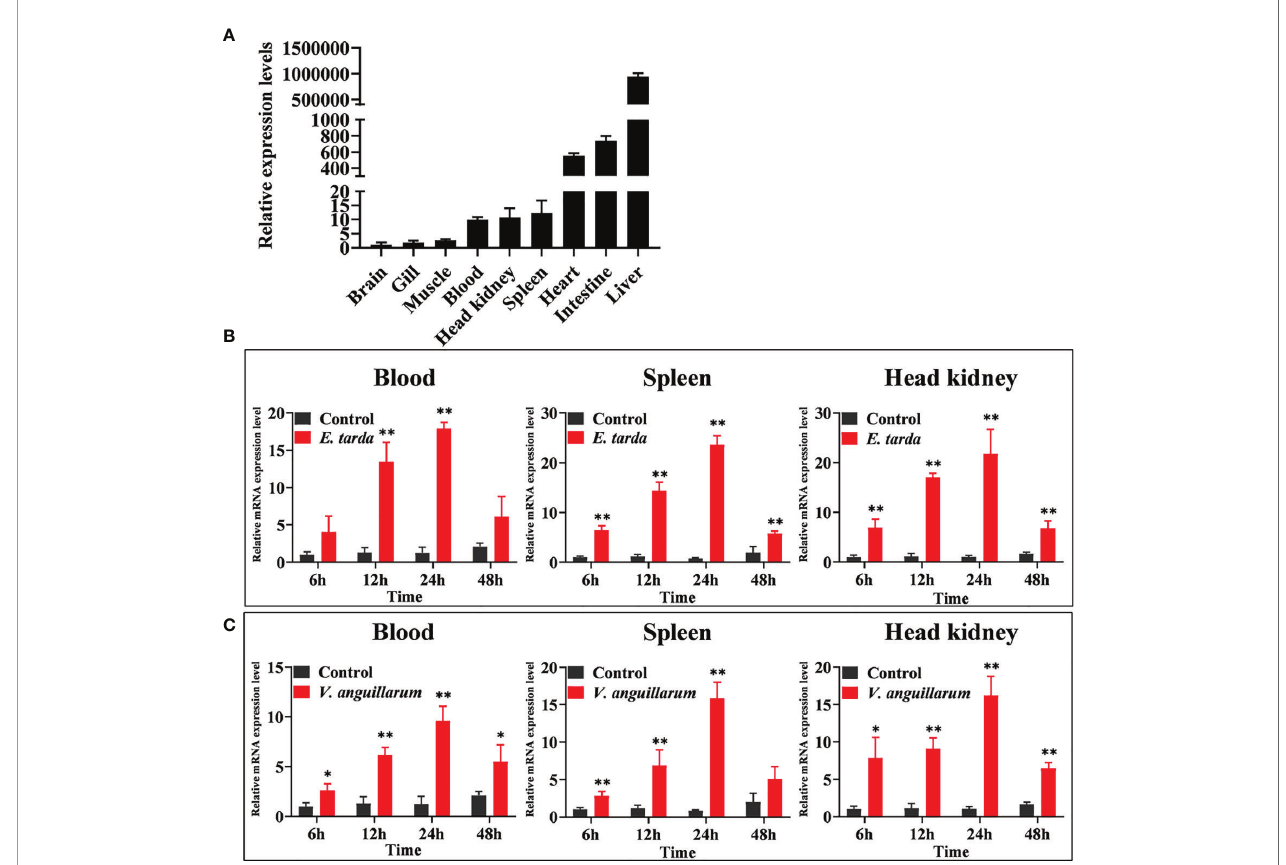
FIGURE 3 | The expression of PoC3 in Japanese fl ounder tissues with and without bacterial infection. (A) PoC3 expression in the brain, gill, muscle, blood, head kidney, spleen, heart, intestine, and liver of Japanese fl ounder was determined by quantitative real time RT-PCR. For convenience of comparison, the expression level in brain was set as 1. (B, C) PoC3 expression after bacterial challenge. Japanese fl ounder were infected with or without (control) Edwardsiella tarda (B) or Vibrio anguillarum (C) and PoC3 expression in blood, spleen, and head kidney was determined by quantitative real time RT-PCR at various time points. In each case, the expression level of the control fi sh was set as 1. Data are shown as means ± SEM (N = 3). N, the number of times the experiment was performed. ** P < 0.01; * P <